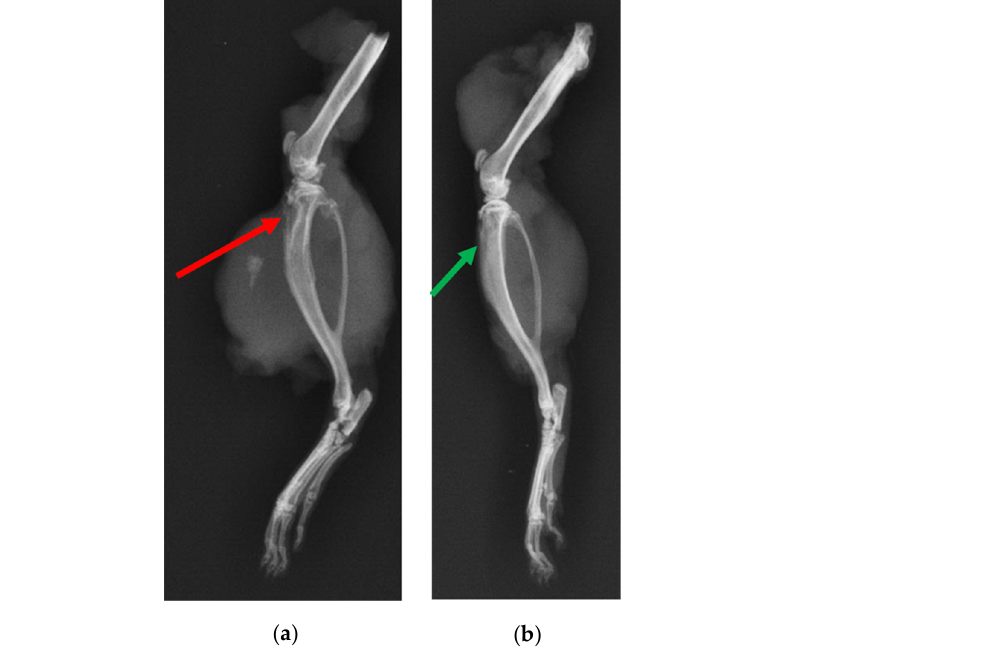
Figure 10. X-ray of rat tibia. ( a ) The red arrow indicates osteomyelitic bone in the control rat. ( b ) Alternatively, the green arrow shows healed bone in the treatment group.